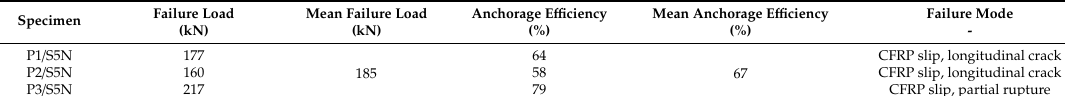
Figure 21. Load-displacement plots for all the specimens in the S5N series. Table 8. Test results of the specimens tested in S5N series.